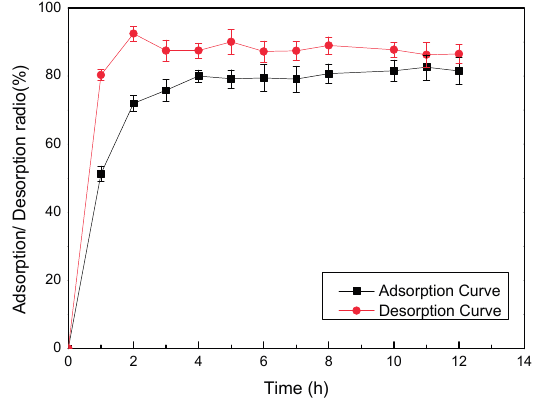
Figure 1. Static adsorption and desorption ratios of AB-8 resin at different time. Results were shown as means ± standard deviation ( n =